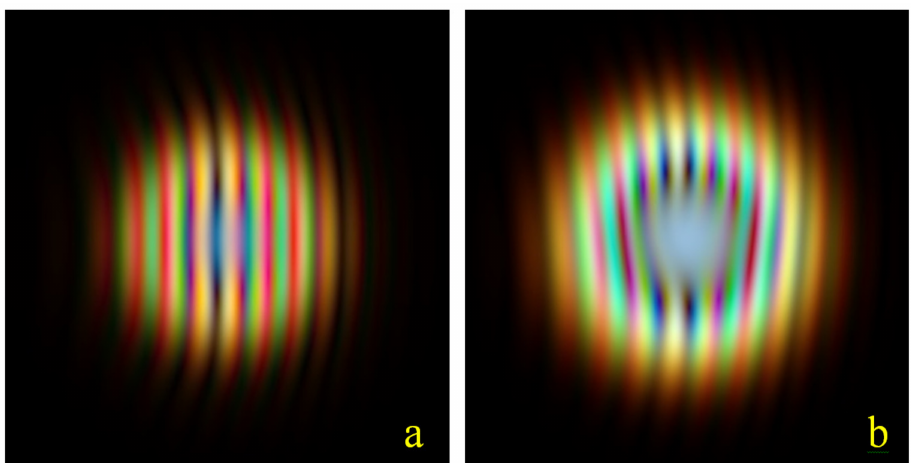
Figure 9. Interference pattern for ( a ) E + , ( b ) E − Bessel–Gauss beam components with l = 0 in a lithium niobate crystal z = 2